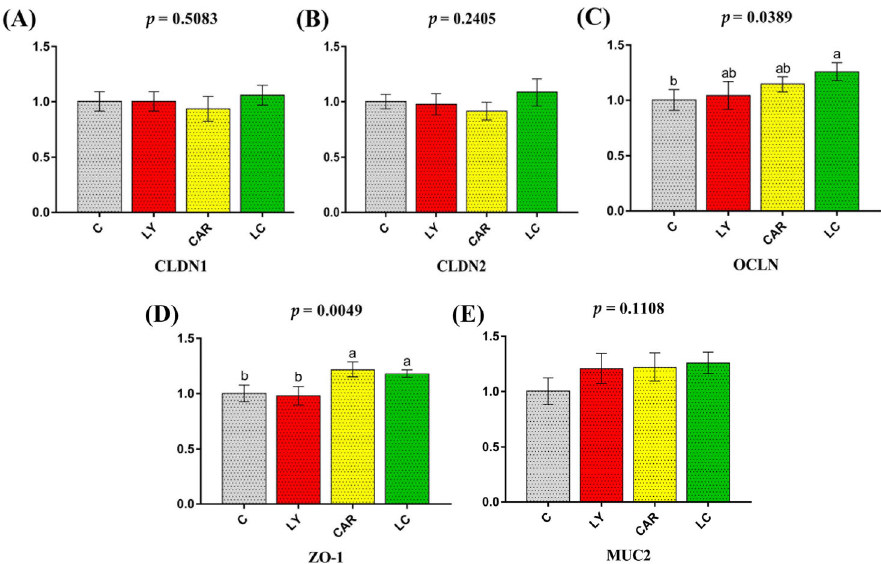
Figure 5. Relative mRNA expression of tight junction genes in the duodenum. ( A ), CLDN1; ( B ), CLDN2; ( C ), OCLN; ( D ), ZO ‐ 1; ( E ), MUC2. Data are presented as mean value ± SEM ( n = 3). Values without the same letter (a, b) represent statistically significant differences ( p > 0.05). Abbreviations: C, Roosters fed a basal diet; LY, Roosters fed a basal diet supplemented with 400 mg/kg Lycopene; CAR, Roosters fed a basal diet supplemented with 150 mg/kg L ‐ Carnitine; LC, Roosters fed a basal diet supplemented with (400 + 150) mg/kg Lycopene and L ‐ Carnitine in combination.